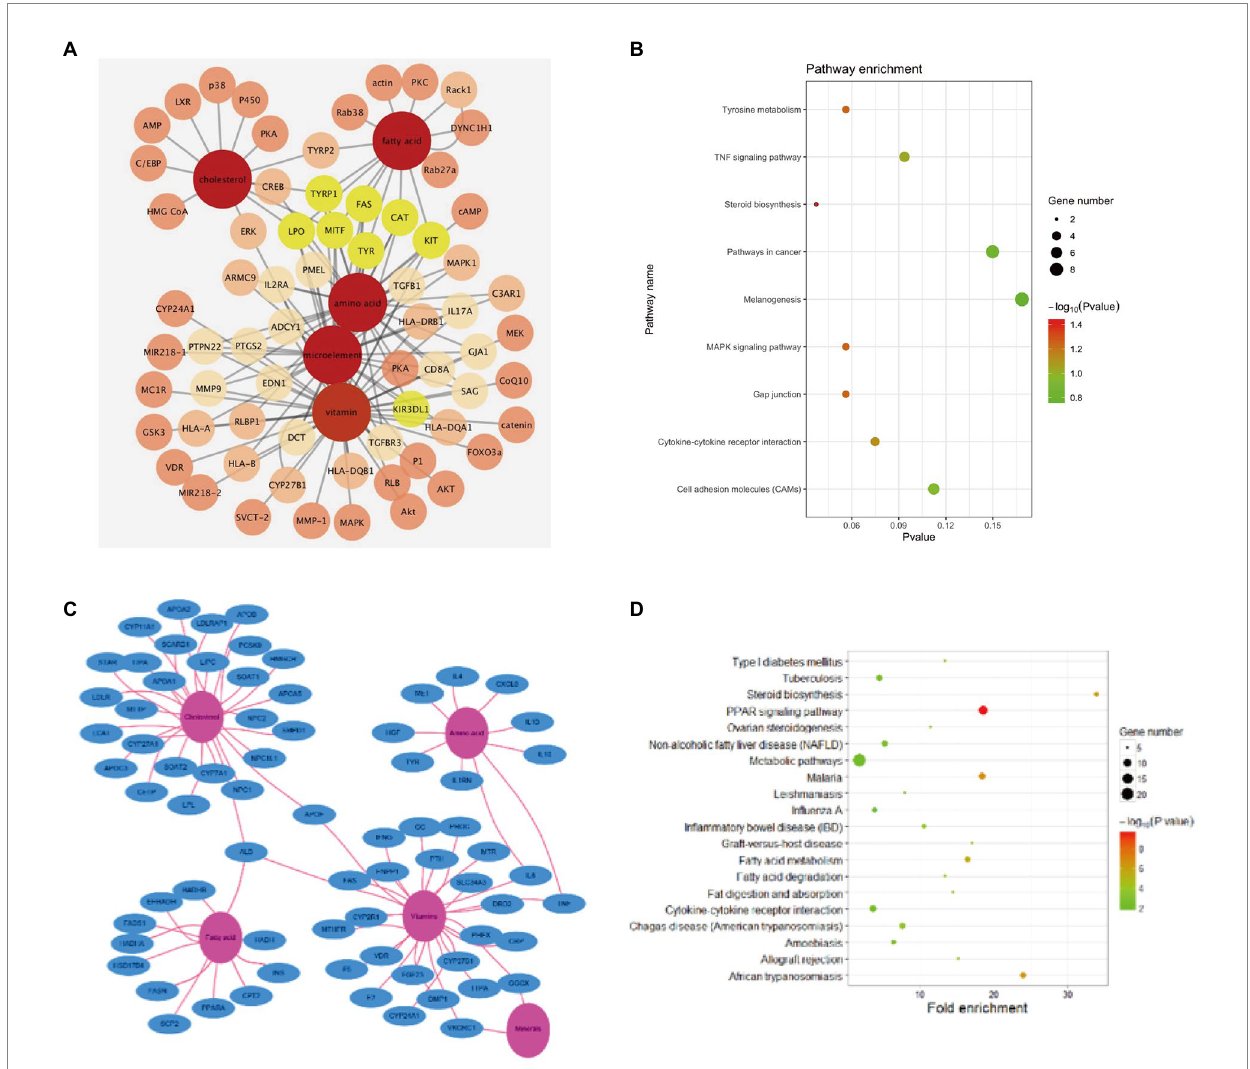
FIGURE 4 Network pharmacology analysis. (A) Components-melanin related targets interaction network. (B) Top 9 KEGG enrichment in DM components- melanin network pharmacology. (C) Components-skin barrier related targets interaction network. (D) Top 20 KEGG enrichment in DM components- skin barrier network